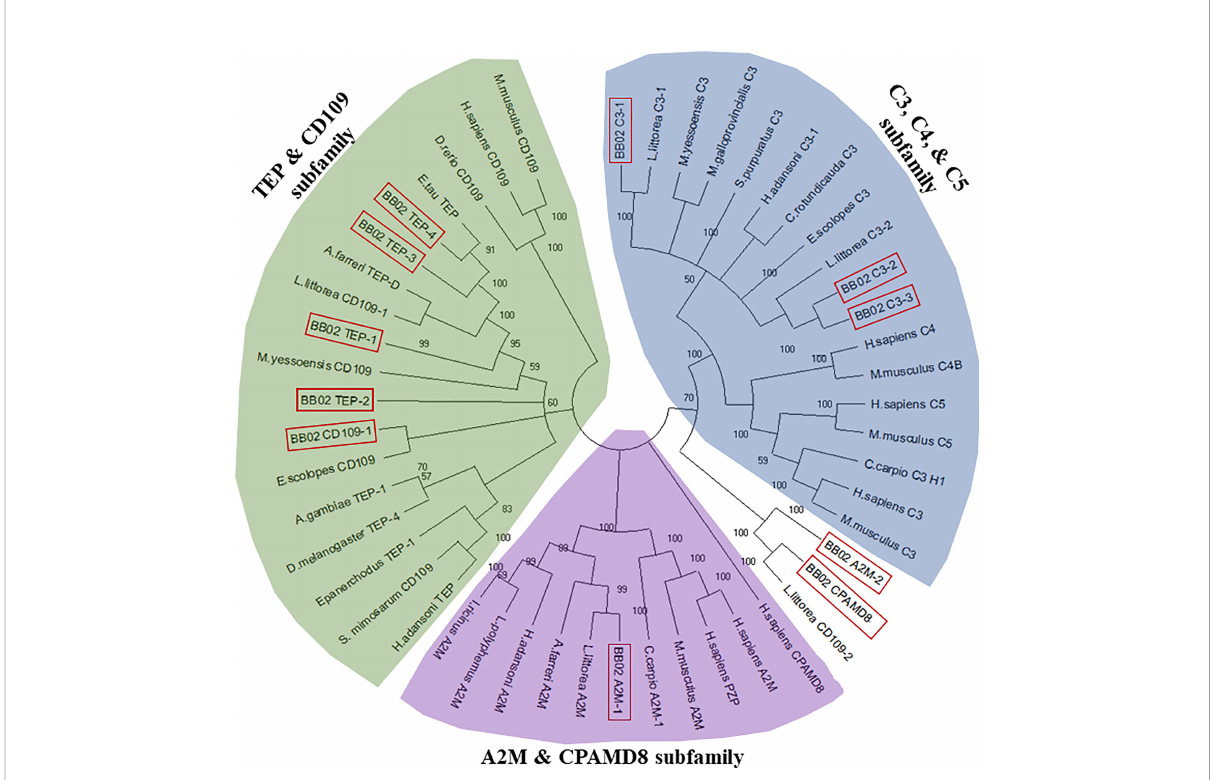
FIGURE 1 Phylogenetic tree of the B. glabrata TEPs among other homologs in the TEP superfamily. BB02 and BS90 B. glabrata TEP protein sequences were aligned with MUSCLE and a phylogenetic tree was constructed utilizing 39 additional full-length TEP protein homologs from diverse animal species. The neighbor-joining statistical method (60), James-Thornton-Taylor model (61), and bootstrap phylogeny test with 500 replications were utilized to construct the unrooted tree with MEGA-X (59). B. glabrata BB02 protein sequences are marked in red boxes. The homolog sequences used and their accession numbers can be found in Supplemental Table